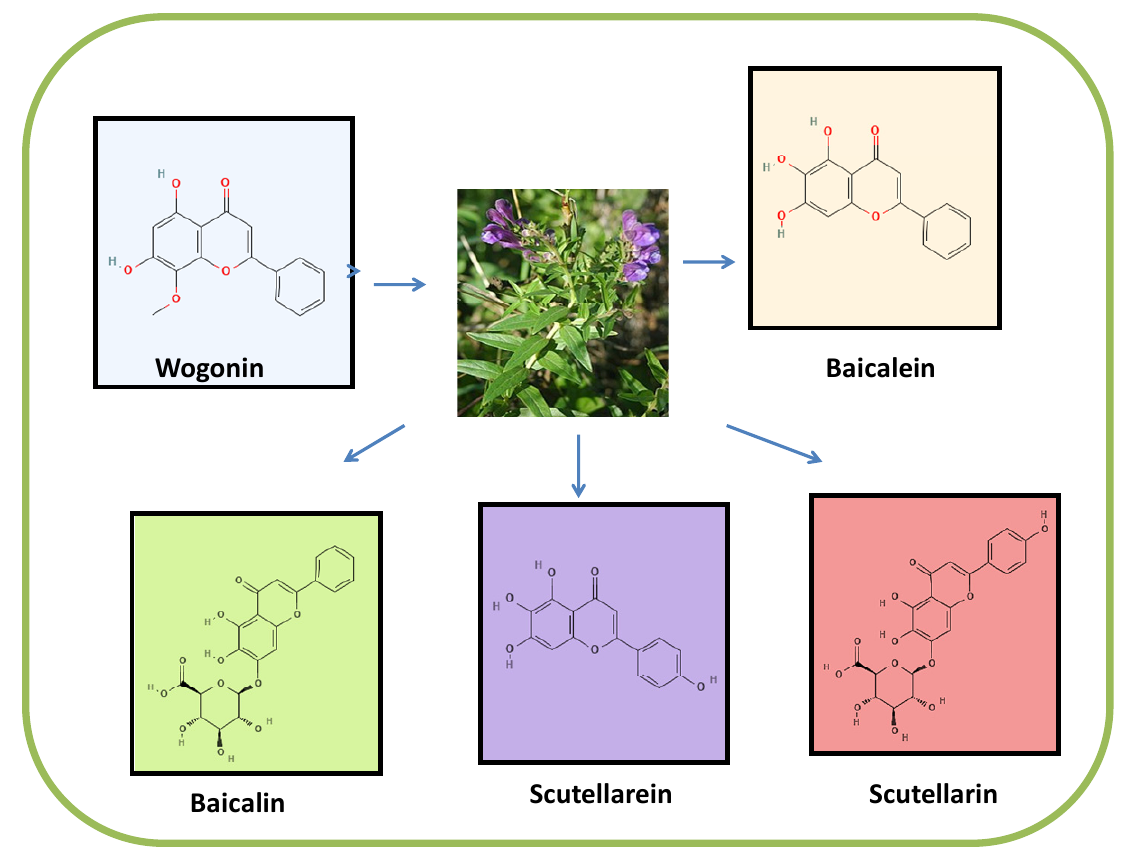
Figure 1. The most important flavone constituents of Scutellaria